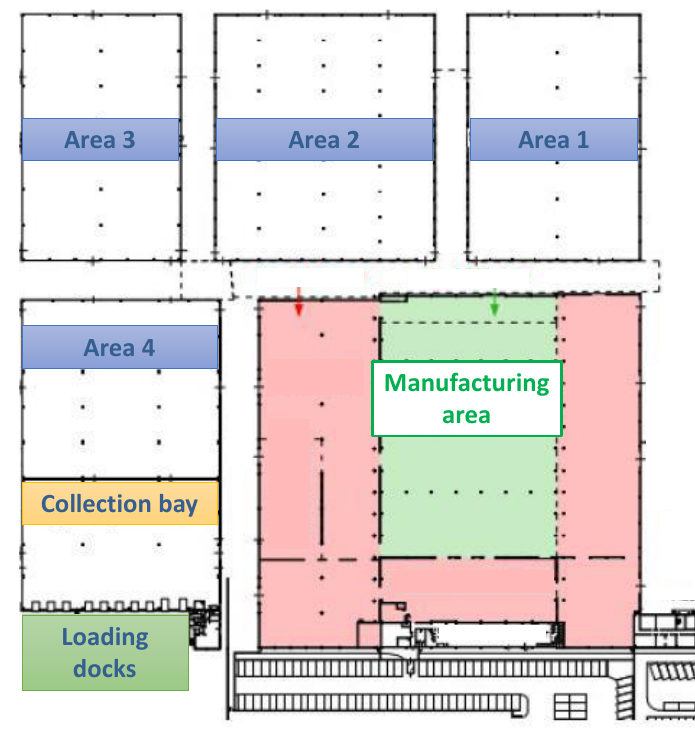
Figure 1. Tassignano warehouse